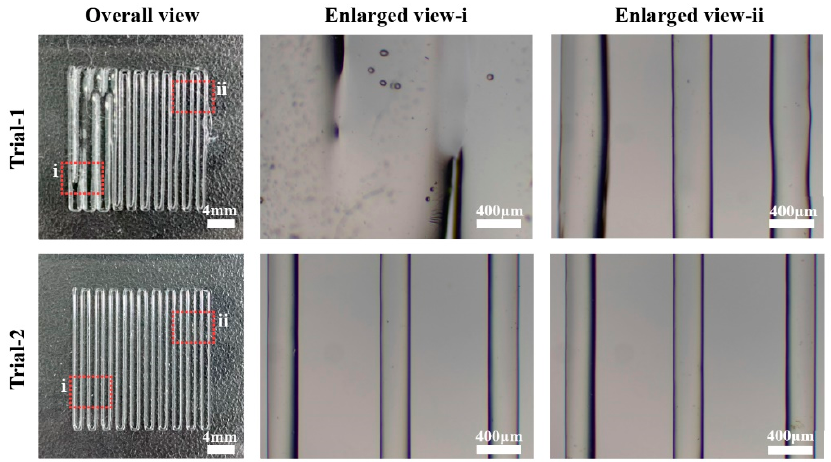
Figure 10. Photographs and micrographs of printed structures.